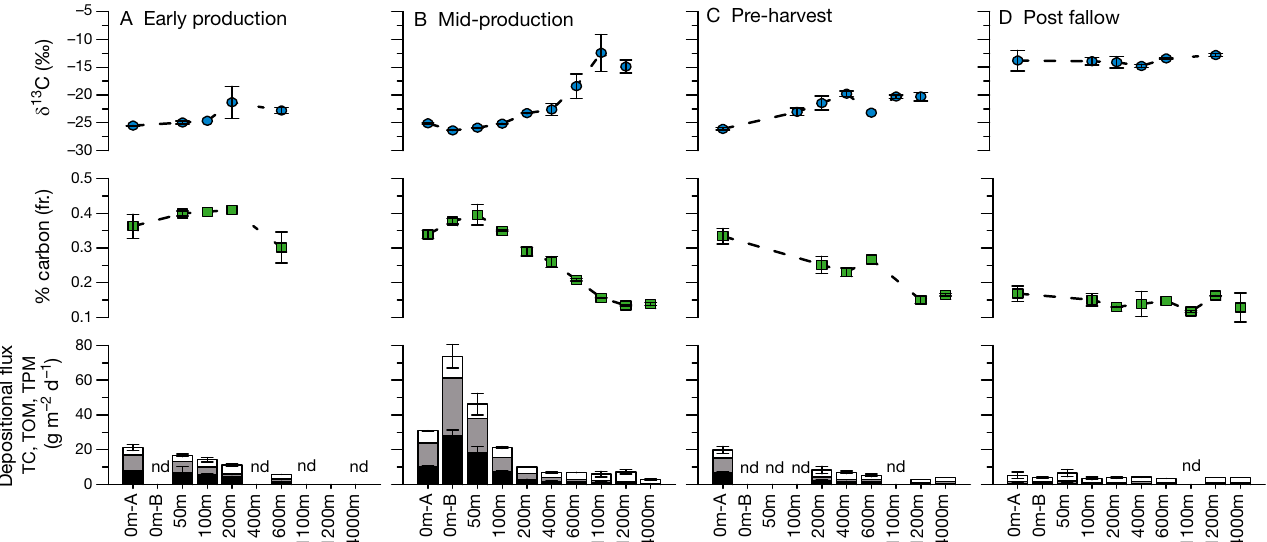
Fig. 4. Depositional fluxes during the 4 survey periods. Top 2 rows of plots: δ 13 C and % carbon composition of particles (fraction) near-bottom (2.5 m above bottom [mAB]). Bottom row: rate of depositional flux measured by total particulate matter (TPM, top of white bars), total organic matter (TOM, top of grey bars) and total carbon (TC, black bars) for 2.5 mAB. Error bars